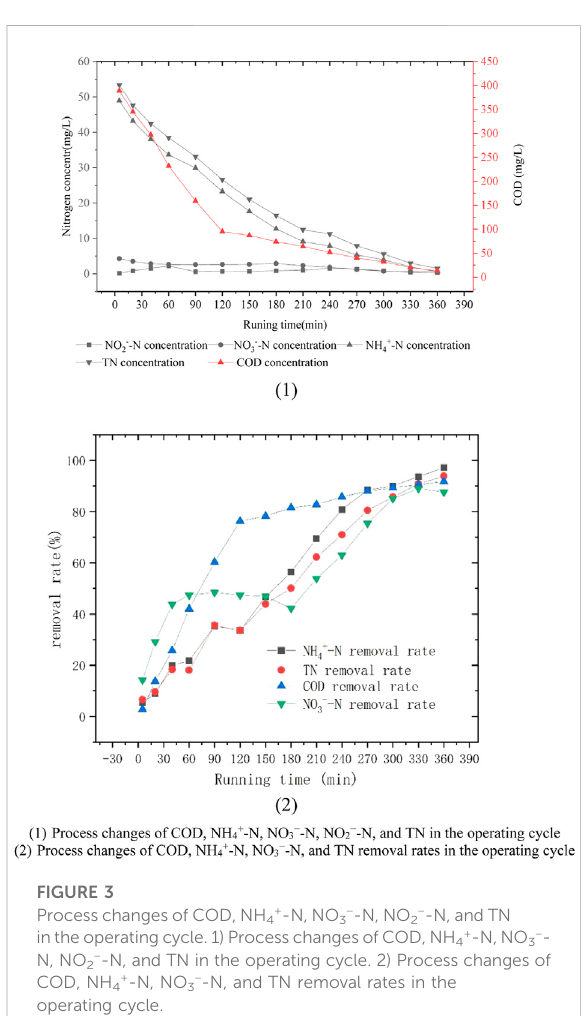
FIGURE 3 Process changes of COD, NH 4 + -N, NO 3 − -N, NO 2 − -N, and TN intheoperatingcycle.1)ProcesschangesofCOD,NH 4 + -N,NO 3 − - N, NO 2 − -N, and TN in the operating cycle. 2) Process changes of COD, NH 4 + -N, NO 3 − -N, and TN removal rates in the operating